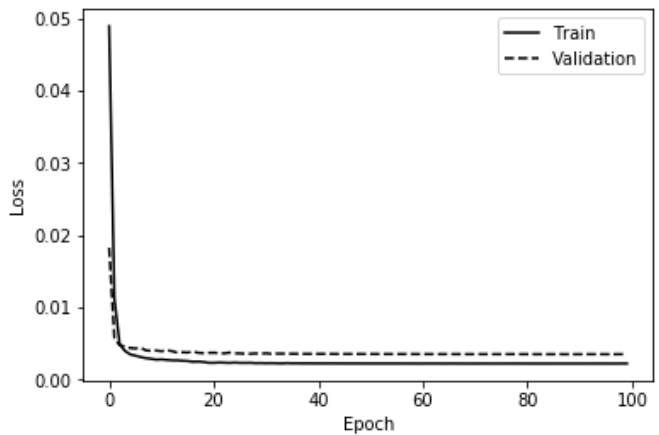
Figure 6. Training and validation accuracy of the deep ANN.